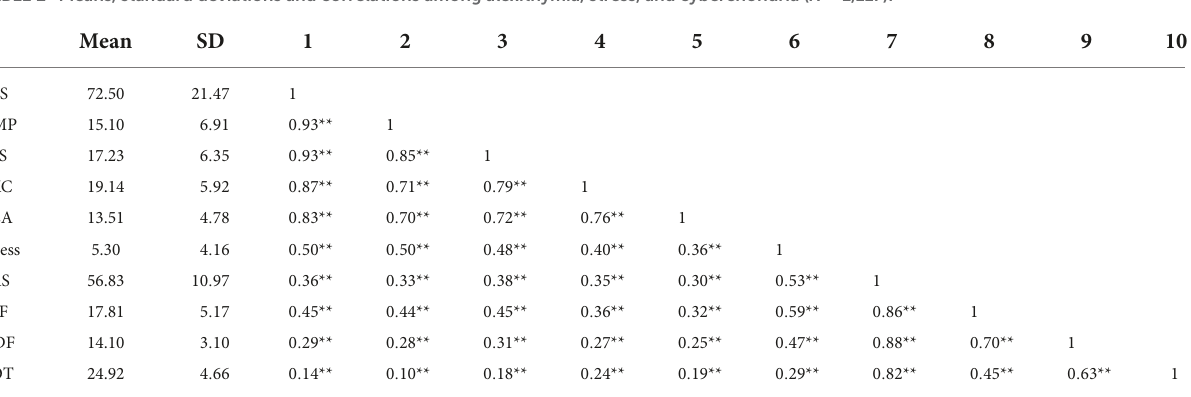
TABLE 2 Means, standard deviations and correlations among alexithymia, stress, and cyberchondria ( N =